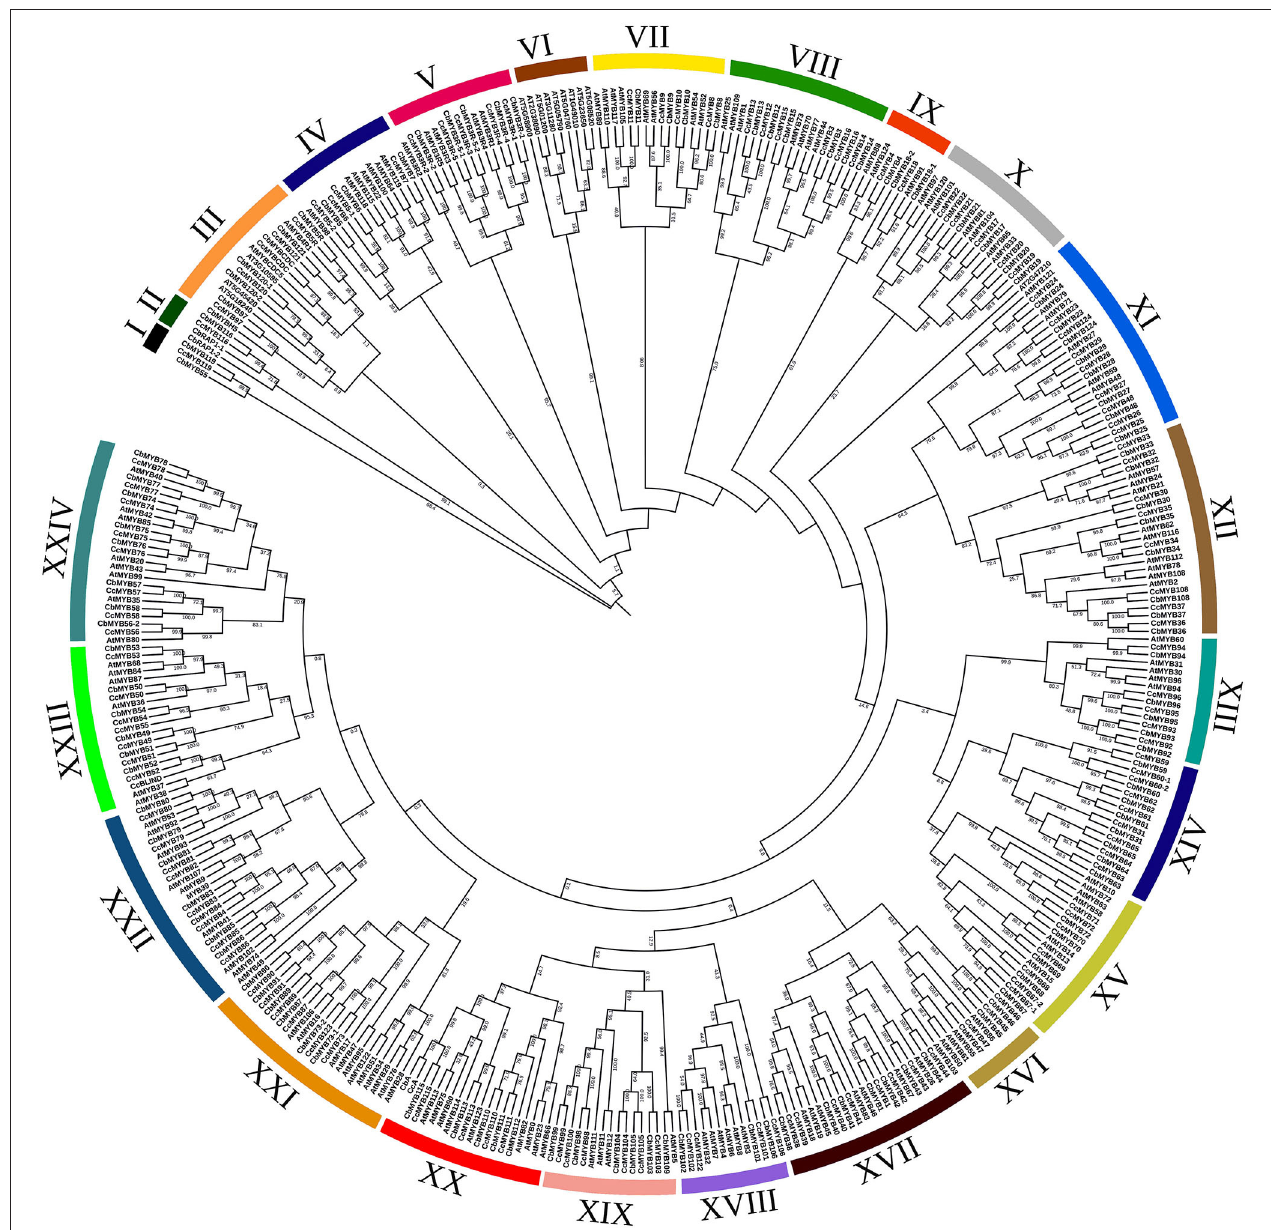
FIGURE 4 | Phylogenetic tree constructed using R2R3 MYBs from C. chinense , C. baccatum, and Arabidopsis. The tree was divided into 24 subgroups, and bootstrap values are shown on the branches of the tree.